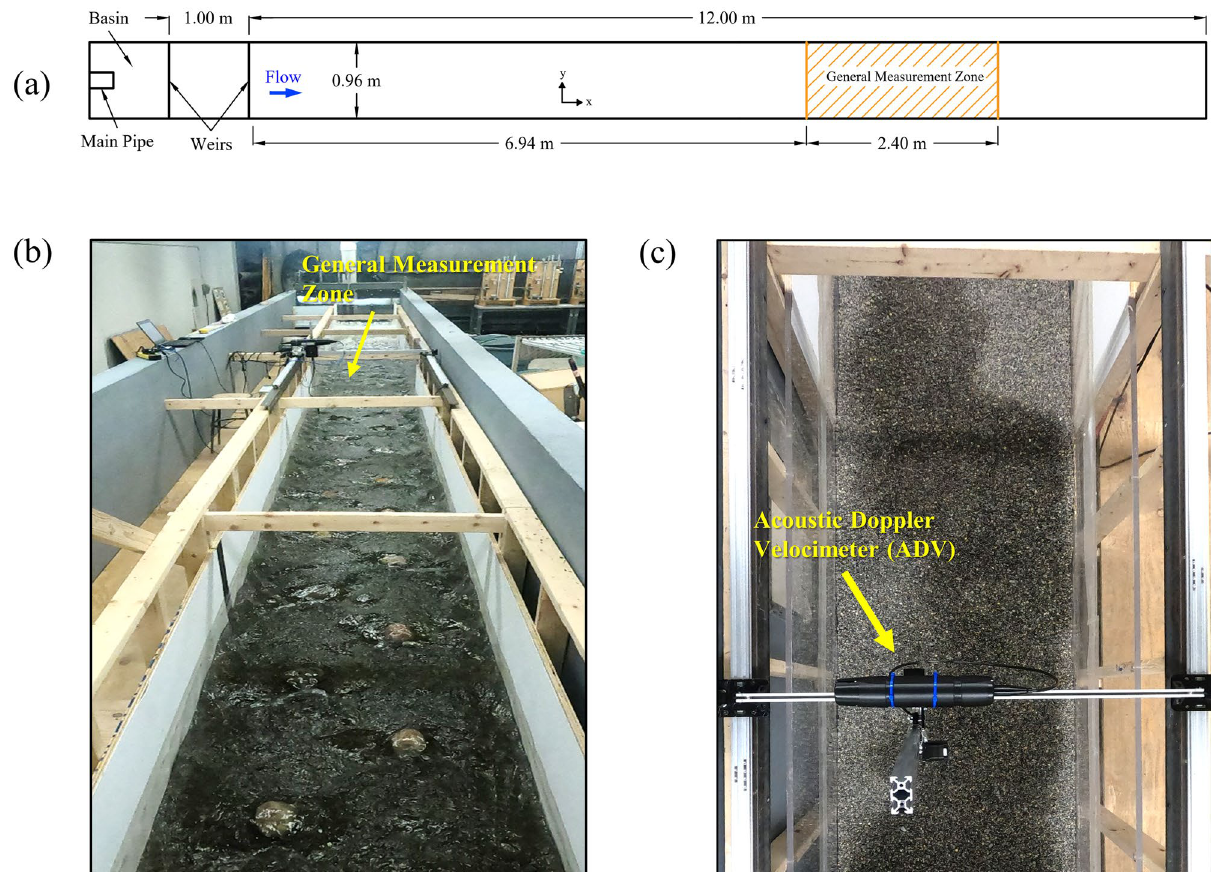
Figure 1. ( a ) A simplified plan view of the flume; ( b ) a view of the flume (facing upstream) during the experiments; ( c ) a plan view of the general measurement zone within the d 50 = 6.1 mm, and d 90 = 8.8 mm, where d p is the particle size for which p % of the particles are finer. As this study is not focusing on flow variations over a movable bed, the gravel layer was fixed to the bed to prevent possible sedi- ment erosion and deposition, specifically near the boulders. The bed slope was set at S 0 = 0.005 representing low- gradient streams 42 which normally provide high-quality habitat and have been recommended for restoration using instream structures 42 . Bed levels and water surface elevations were measured in the general measurement zone over a grid with 50 mm spacing in both x and y directions. The average of bed level variations was consid- ered as the mean bed level (virtual bed level), where z = 0. Therefore, z is defined as the vertical distance from the mean bed level. By subtracting the mean bed level from the measured water surface elevations, the flow depth for each point was obtained and the reach-averaged flow depth, H , was calculated by taking the average of the flow depths over the measurement grid. A down-looking acoustic Doppler velocimeter (ADV) was used to per- form velocity time-series measurements. The ADV was mounted on a carriage in the general measurement area, which enabled the automatic movement of the ADV in three dimensions with a resolution of 0.1 mm (Fig. 1c). Experimental scenarios. In total, eight experimental scenarios were conducted, including six scenarios with boulder placement and two scenarios without boulders as the reference scenarios. For scenarios includ- ing boulders, natural spherical-shape boulders with an equivalent size of D l = 0.12 m in length and width, and D h = 0.10 m in height were used. Several research studies have referred to large roughness elements with a similar size as boulders 36,41,43–45 . Boulders have also been referred to as large roughness elements that are not trans- ported by flow 45 . However, it should be noted that following geological classifications, for the flume scale (1:1), the diameter of large roughness elements in this study falls in the range of cobbles (64 to 256 mm) rather than boulders (> 256 mm) 46 . To keep consistency with the literature, we refer to large roughness elements in this study as boulders, as well. Additionally, by applying the results to larger scales (e.g., for larger rivers and streams), the large roughness elements in this work may be classified as boulders 46 . A combination of two different flow rates ( Q ) and four boulder concentrations ( λ ) was used to design eight experimental scenarios. Two flow rates of Q = 0.060 and 0.075 m 3 /s were used to represent the low and high flow conditions. The selection of the mini- mum flow rate was restricted by the required minimum depth for the ADV measurements, and the high flow rate was selected in a way to minimize the possibility of bed abrupt detachment and boulder displacement during the experiments. Four boulder concentrations, λ = 0 (no boulder), 3.4, 5.4, and 8.3% were used to cover